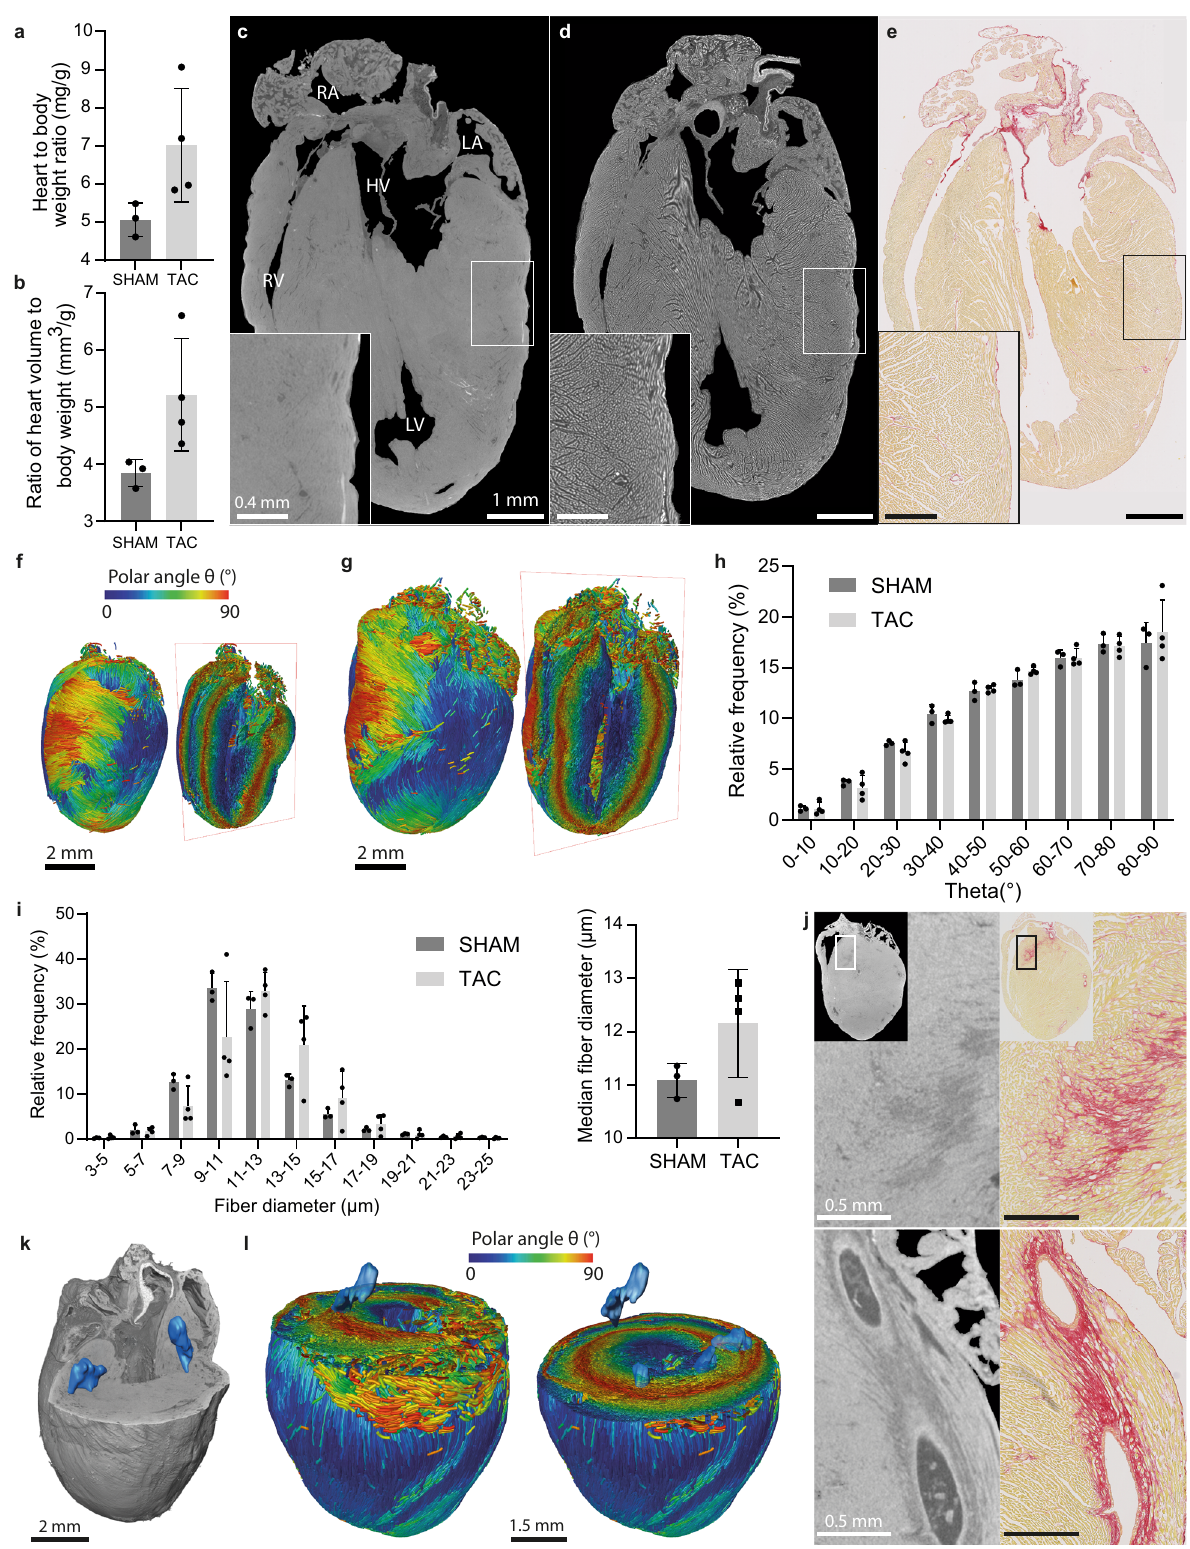
muscle tissue (Fig. 2), whereas collagen fi bers in tendon tissue were optimallyvisualizedafterfastfreezingwithisopentaneat − 20°C(Fig.3). This demonstrates that, given an optimized freezing rate, diverse types of tissue constituents can be effectively visualized using